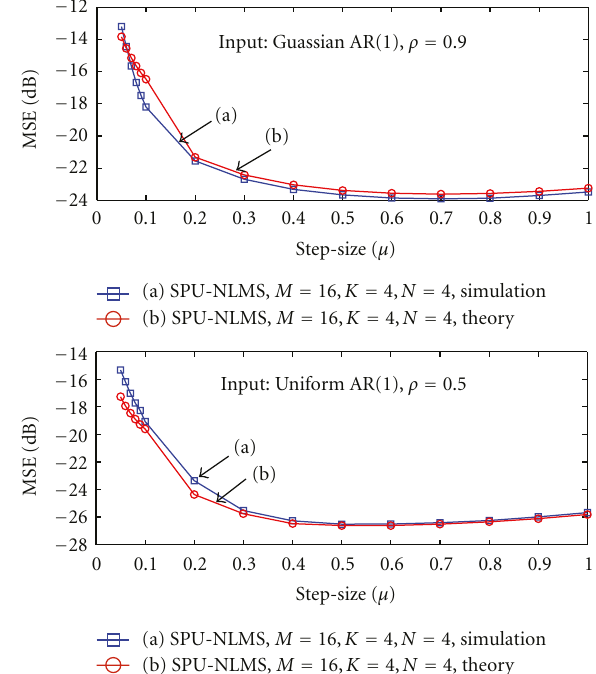
Figure 17: Steady-state MSE of SPU-NLMS with M = 16, K = 4, and N = 4 as a function of the step size in nonstationary environment for di ff erent input